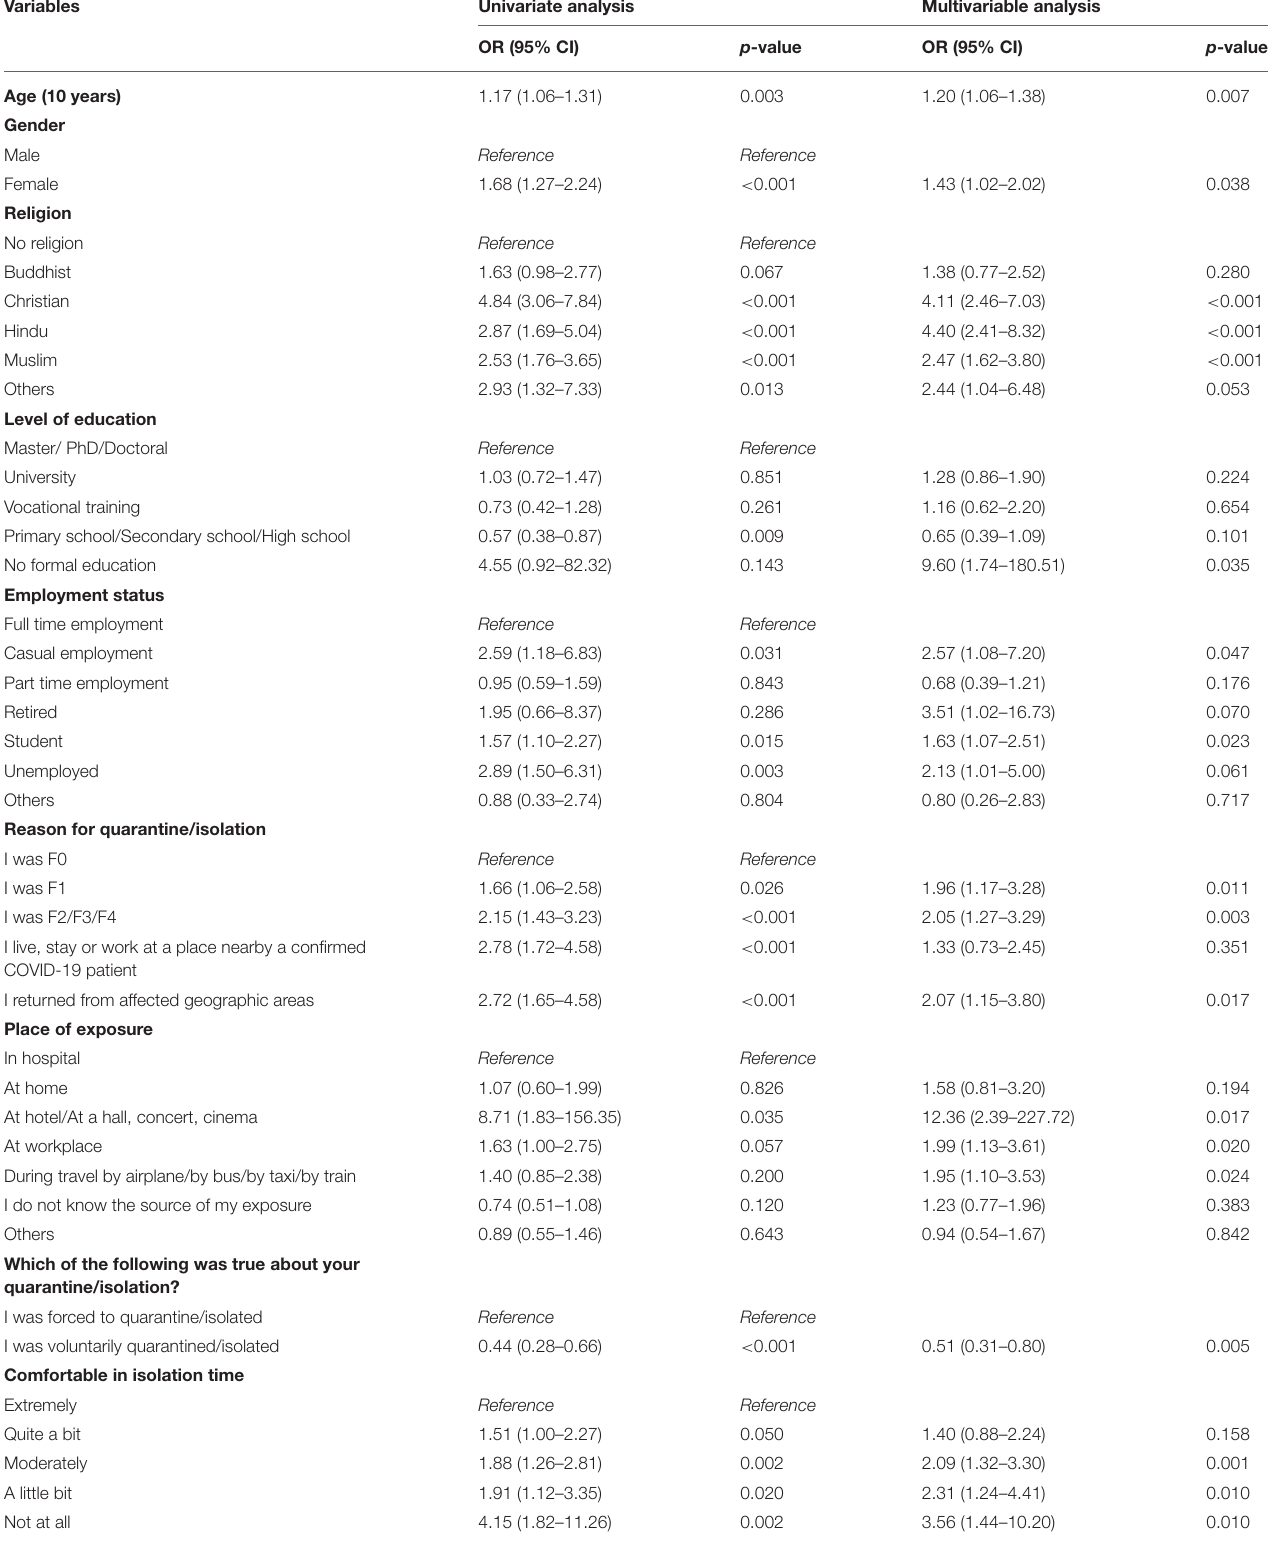
TABLE 2 | Multivariable logistic regression analysis for factors associated with perceived stress among the quarantined/isolated